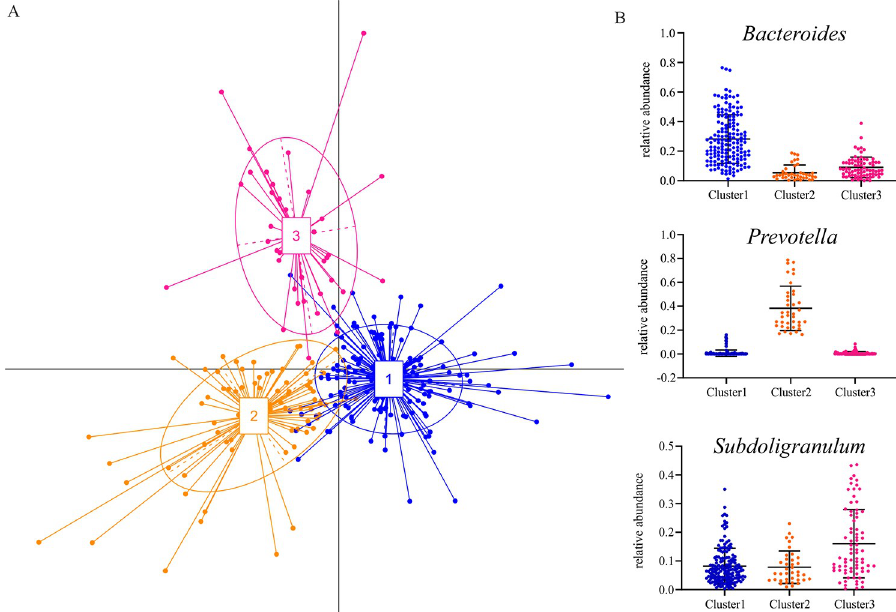
Fig 2. Intestinal microbial enterotypes. (A) Based on the abundance of microbial genera, three enterotypes were identified in the cohort using Between Class Analysis that visualizes results from Principal Component Analysis and clustering. (B) The relative abundances of the proposed drivers of these three enterotypes, the genera Bacteroides , Prevotella and Subdoligranulum , are shown for each subject.